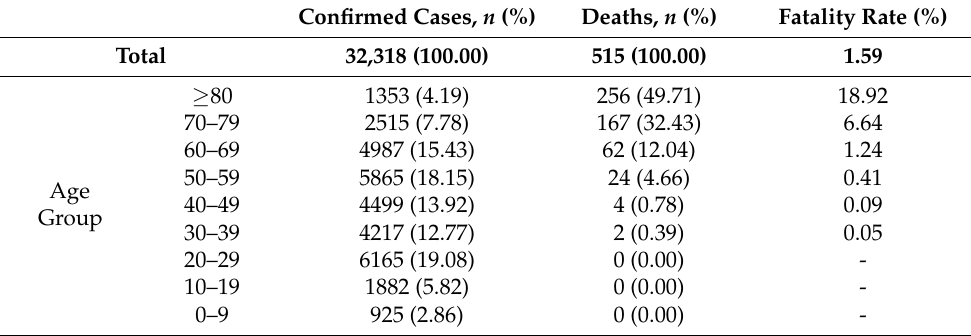
Table 1. Distribution of the cases by sex and age groups (as of 26 November 2020)